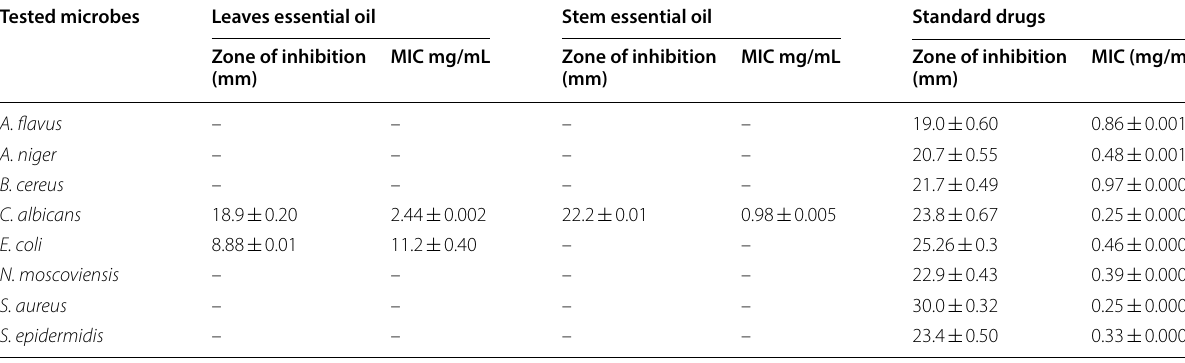
Values are mean S.D of three separate experiments (P < 0.05) ± Rifampicin and fungone were used as standards for bacterial and fungal strains respectively